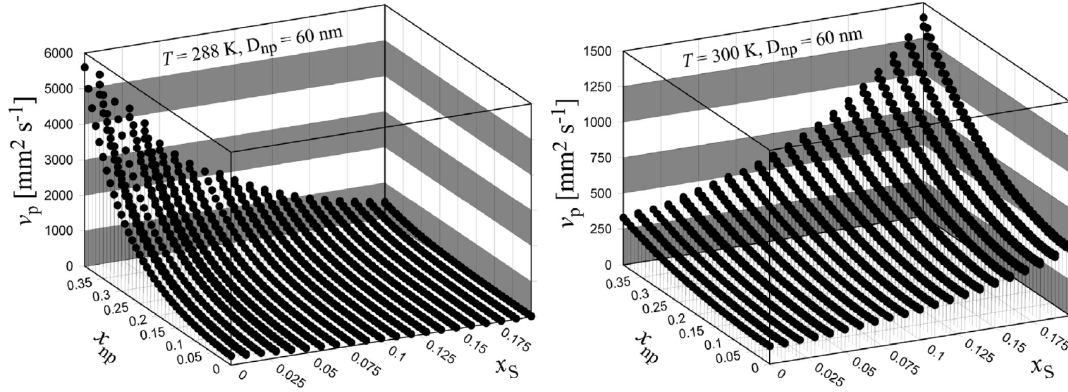
Figure 9. Effect of surfactant mass fraction ( Χ S ) and temperature on Al 2 O 3 nanolubricant ( Χ np ) viscosity [31].